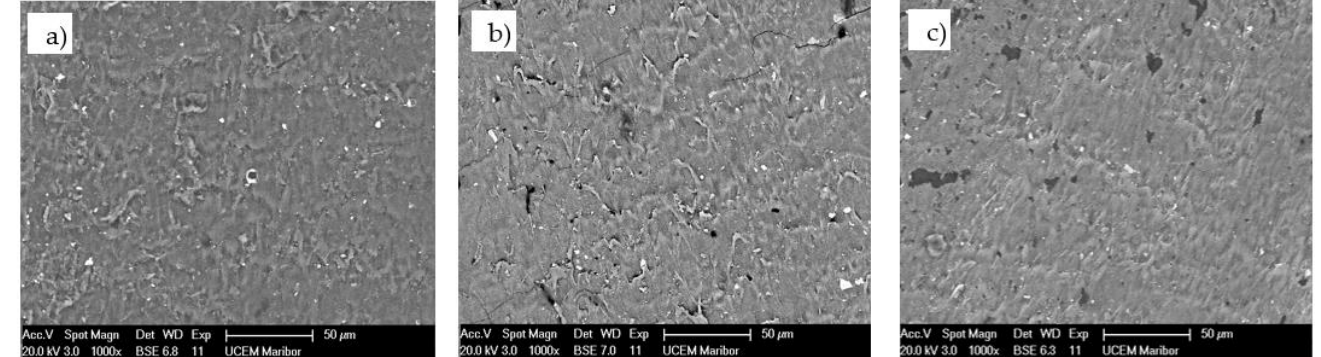
Figure 4. SEM micrograph of the POM-gear without coating ( a ), SEM micrograph at site 1 ( b ), SEM LFD micrograph at site 2 ( c ).